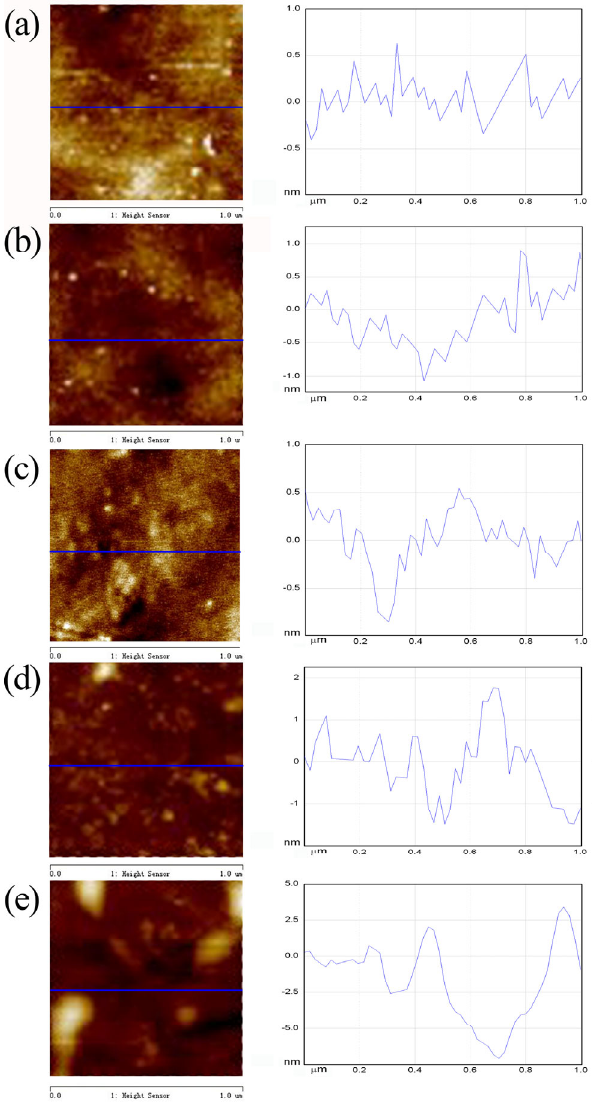
Fig. 7 AFM images of (a) original silicon surface and that of the surfaces polished by SiO 2 particles with a diameter of (b) 100 nm, (c) 500 nm, (d) 2 µm, and (e) 5